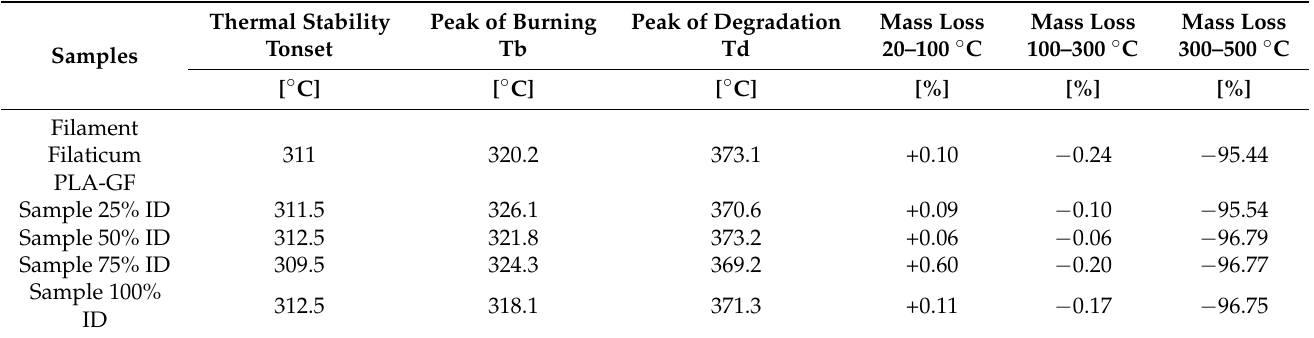
Table 4. Thermal stability (Tonset) and degradation peak (Td) temperatures and mass loss of Filaticum PLA-GF filament and FFF